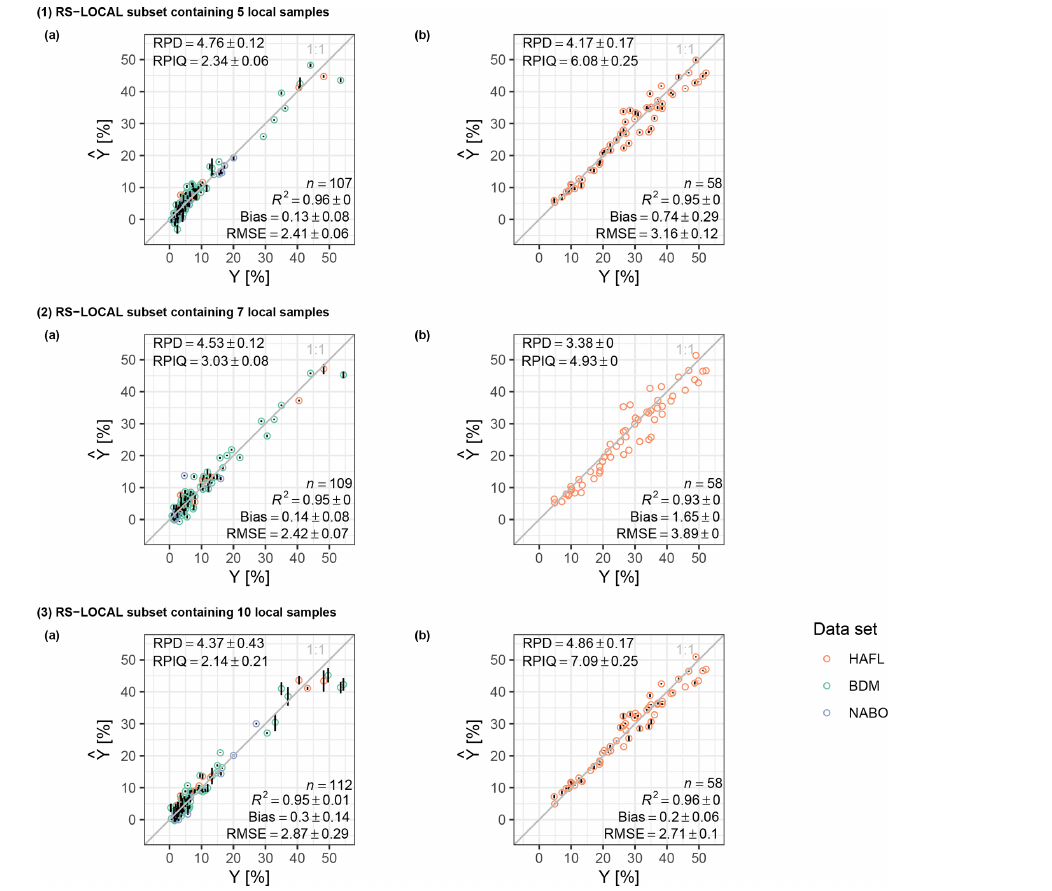
Figure F1. Predicted ( ˆ Y ) vs. observed ( Y ) total carbon content (percent) by calibrating a PLSR of a RS-LOCAL subset with five (1), seven (2) and 10 (3) local HAFL samples (a) and validating each with 58 local HAFL samples (b) , respectively. The error bars signify the SD, and where none are present, the components remained identical across five repetitions and, thus, SD =